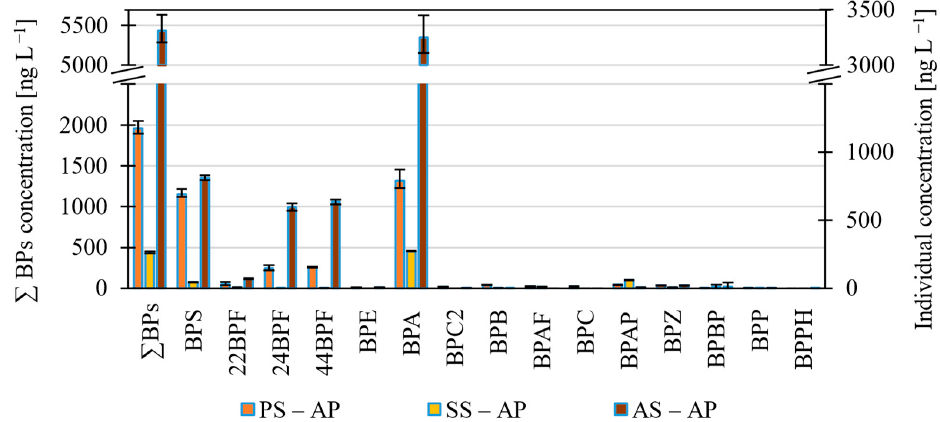
Figure 3. Histogram showing levels of BPs in the aqueous phase of primary (PS–AP), secondary (SS – AP), and anaerobically stabilized sludge (AS– AP).